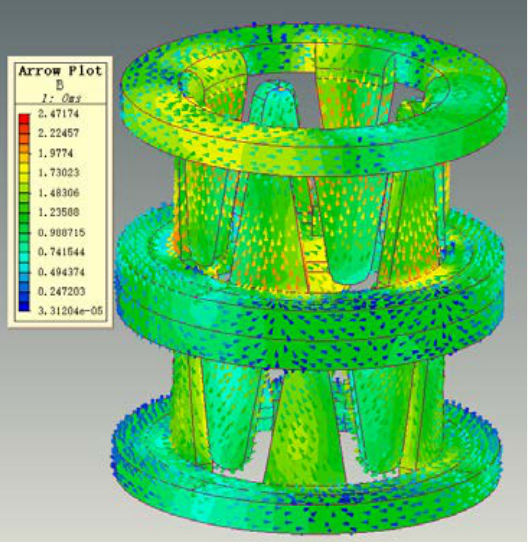
Figure 4. The magnetic circuit diagram of a micro claw-pole stepper motor.